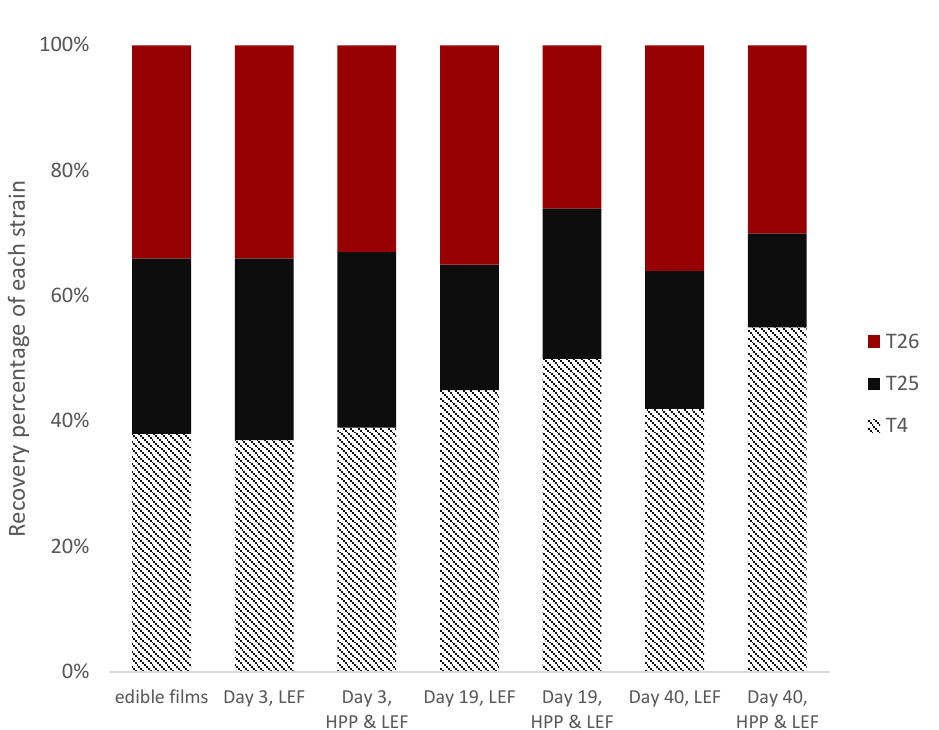
Figure 2. Isolate distribution (%) of the added functional LAB strains (T4, T25, and T26) recovered from edible films and from cheese slices at three time points (day 3, day 19 and day 40) during storage at 4 °C, with (HPP & LEF) or without (LEF) HPP.